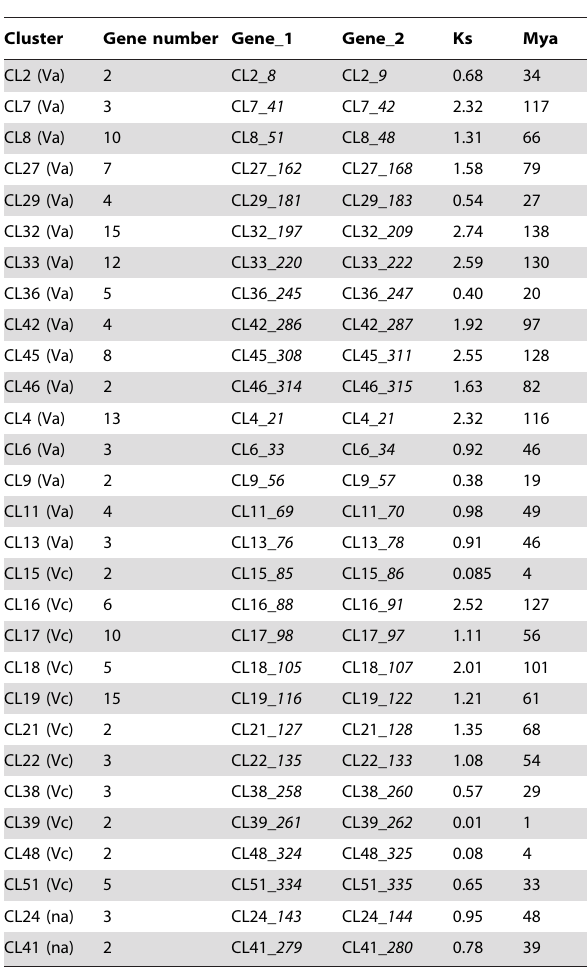
Table 3. Estimated time of homogeneous NBS - R cluster